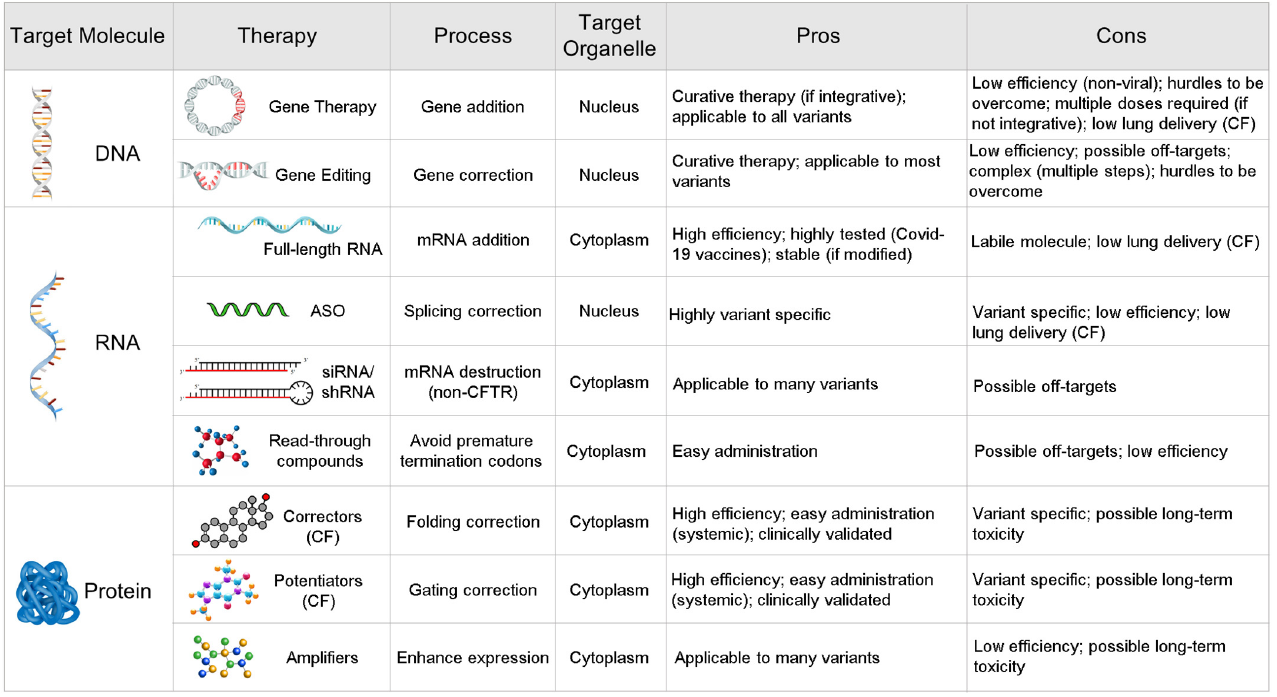
Figure 1. Comparison of current therapeutic strategies for genetic diseases targeting DNA, RNA and Protein. Some categories refer specifically to drugs developed for CF [16]. Protein. Some categories refer specifically to drugs developed for CF